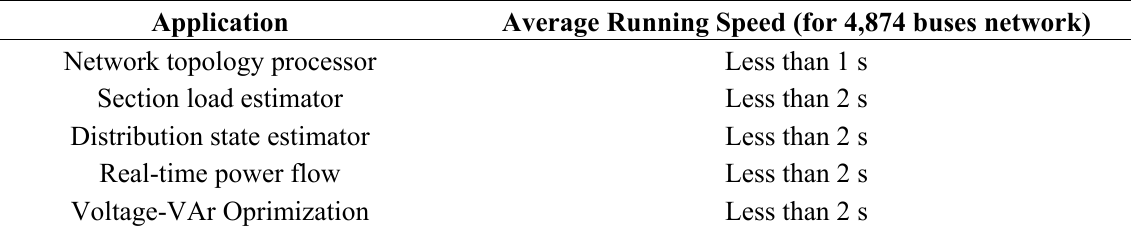
Table 6. Test results of application running speed test.